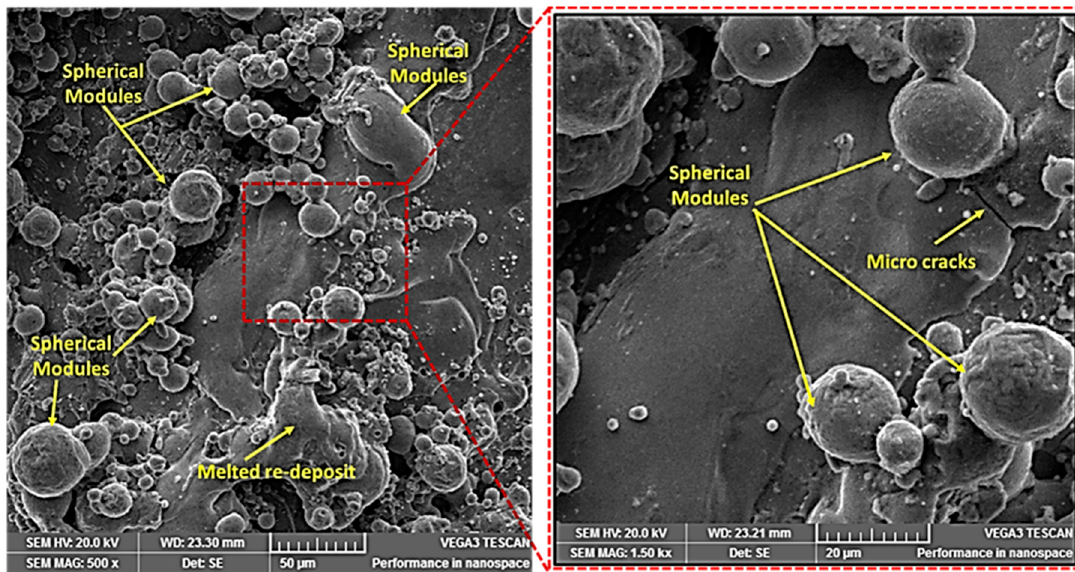
Figure 10. SEM of machined specimen at 200 mm N OD .